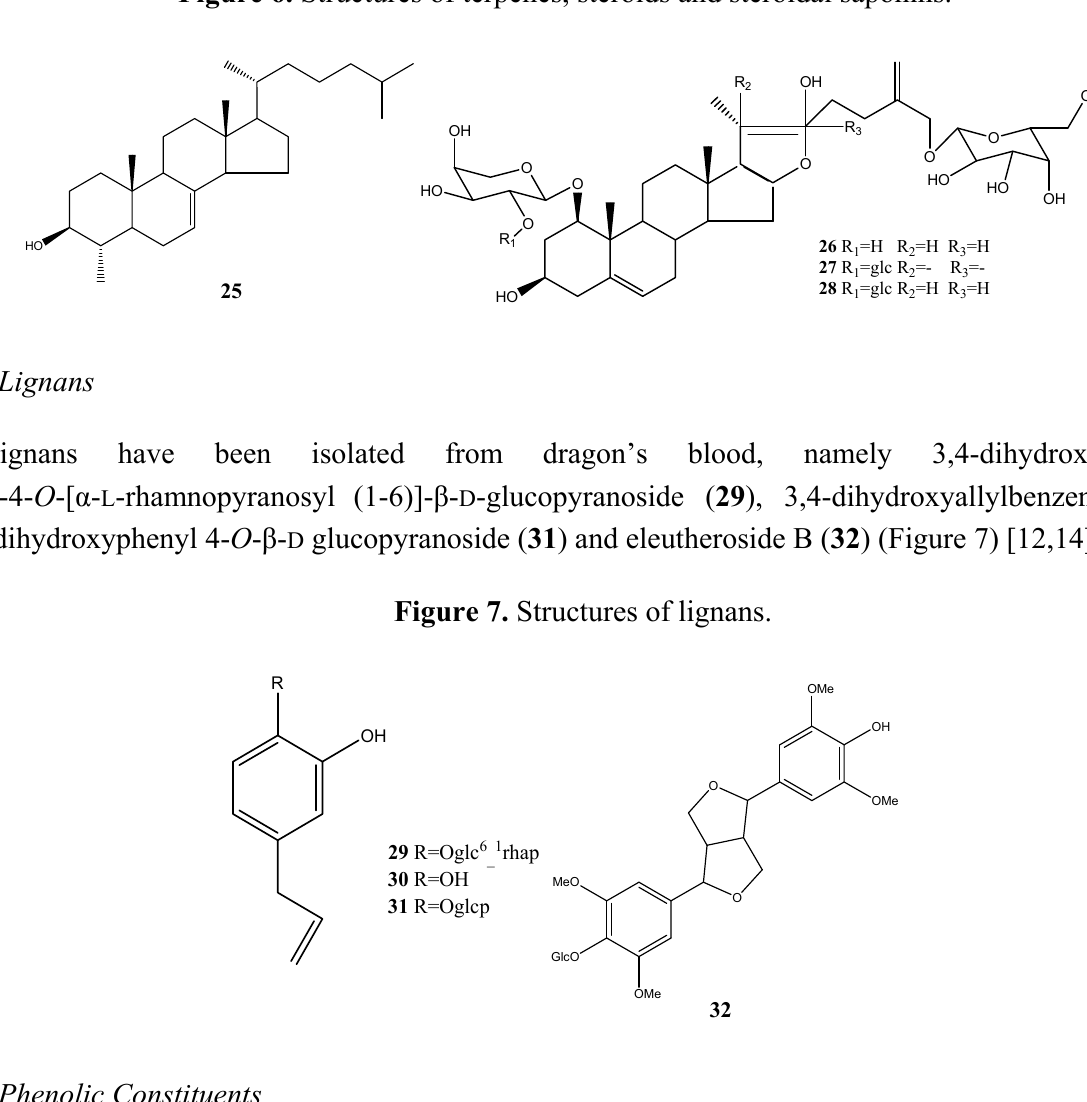
Figure 6. Structures of terpenes, steroids and steroidal saponins.